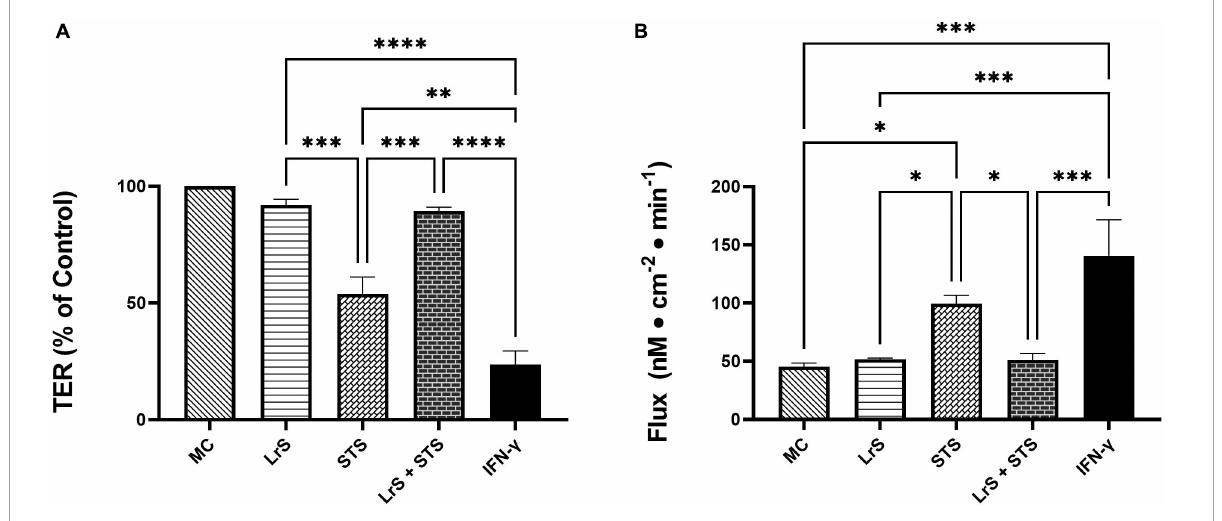
FIGURE5 The LrS attenuates STS-induced damage to T84 IEC monolayer integrity and permeability. (A) Transepithelial resistance (TER) was measured following challenge of T84 IECs with the LrS, STS, combined secretome challenges, or IFN- γ (100 ng/mL) for 24 h ( n = 4). (B) T84 IEC monolayer permeability was determined by measuring the amount of flux of FITC-dextran following challenge ( n = 4). Significance is indicated as ∗ p < 0.05, ∗∗ p < 0.01, ∗∗∗ p < 0.001, ∗∗∗∗ p < 0.0001 as determined by one-way ANOVA and Tukey’s post-hoc test.